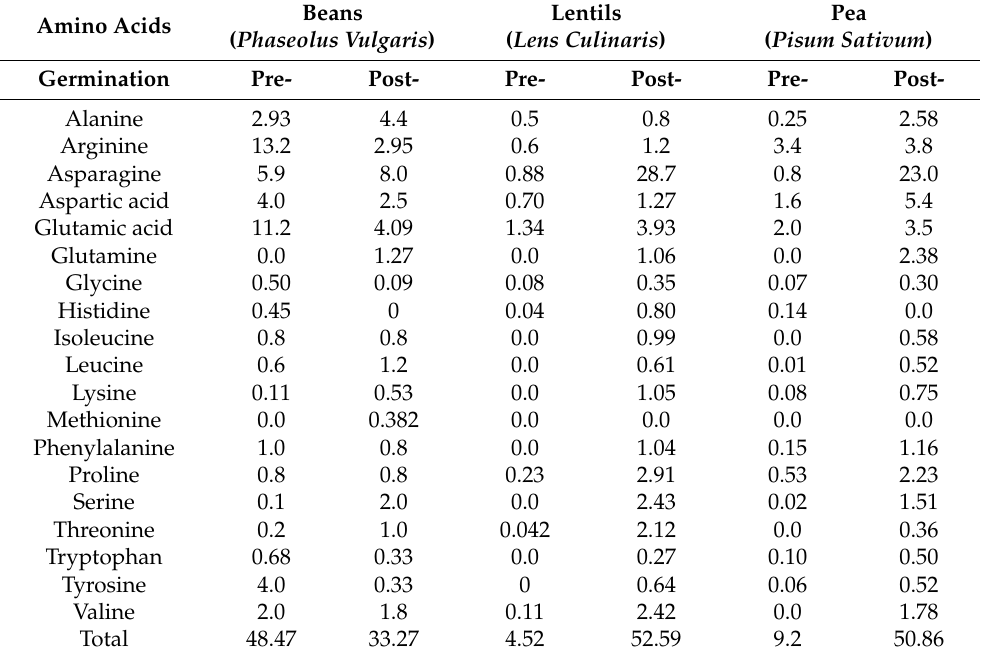
Table 4. Germination-related changes in legume free amino acids (in mg/g dry weight) [60]. Beans Amino Acids ( Phaseolus Vulgaris )